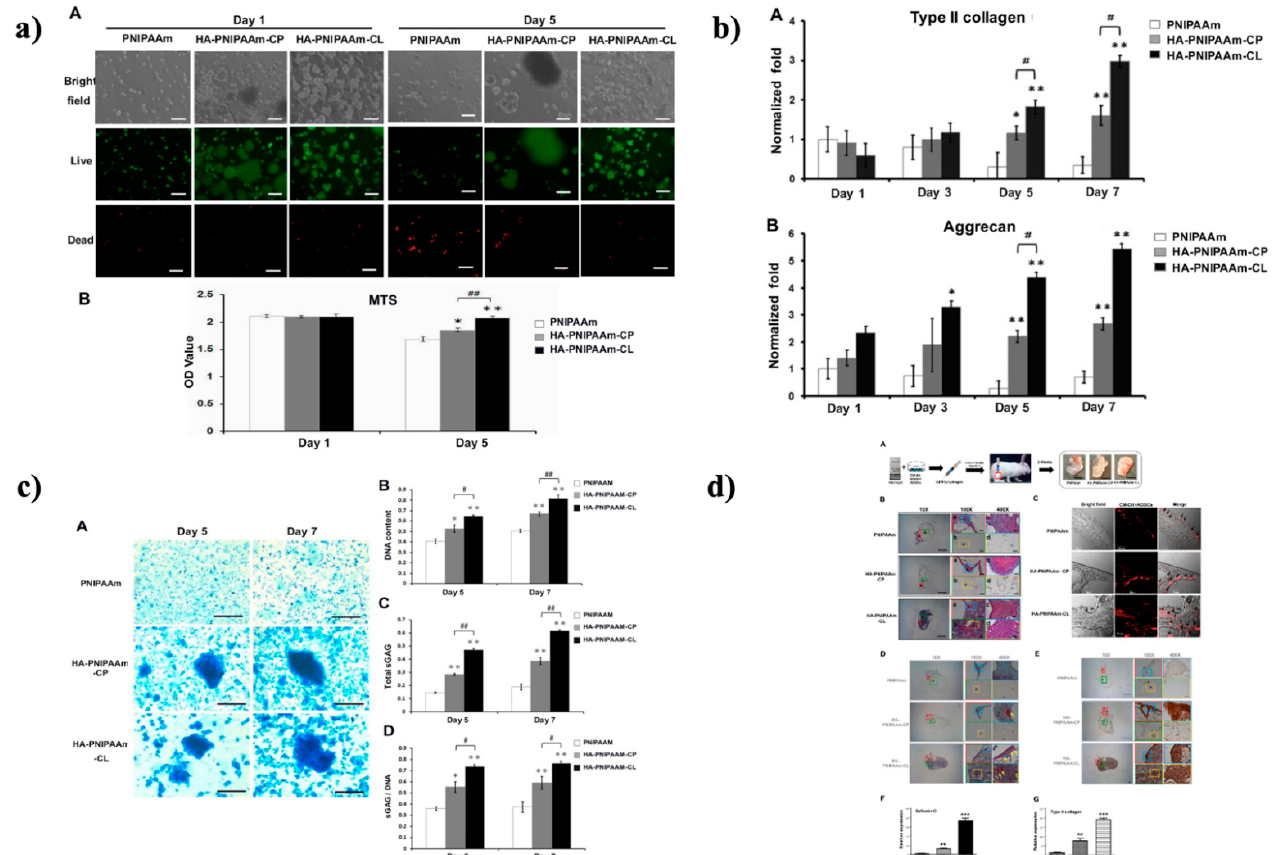
Figure 4. ( a ) The cytocompatibility and cell survival of rADSCs were improved by HA-modified PNIPAM hydrogels. Using (A) live and dead staining and (B) an MTS assay, cell survival of rADSCs encapsulated in PNIPAM, HA-PNIPAM-CP, and HA-PNIPAM-CL hydrogels was determined during days 1 and 5. ( b ) In rADSCs cultivated in PNIPAM, HA-PNIPAM-CP, and HA-PNIPAM-CL hydrogels for 1, 3, 5, and 7 days, the chondrogenic indicators of gene expression of (A) type II collagen and (B) aggrecan were detected. Collagen type II and aggrecan mRNA expression levels in rADSCs cultivated in HA-modified hydrogels are expressed and normalized in comparison to rADSCs cultured in PNIPAM hydrogels, which is designated as 1. ( c ) At days 5 and 7, there was enhanced cell aggregation and cartilaginous matrix sGAG production in rADSC cultured HA-modified PNIPAM hydrogels in vitro. (A) Glycosaminoglycans stained with Alcian blue (sGAG). (B) The DMMB assay was used to quantify the production of sGAG. ( d ) In vivo evaluation of the increase of neocartilage development in rADSCs/HA- PNIPAM-CL constructions using a rabbit model. (A) Illustration of the intraarticular injection of the rADSC/hydrogel constructions into the synovial cavity of rabbit knees. After 3 weeks, injected rADSC/hydrogel constructions were collected from rabbit synovial cavities and analyzed using (B) H&E staining, (C) confocal microscopy for pictures of bright fields, and CM-DiI-labeled rADSCs (red, arrows), (D) safranin-O fast green staining showing sGAG deposition (arrows), and (E) IHC staining for type II collagen synthesis (brown). Normalized relative to the PNIPAM group, which is defined as 1. Quantification examination of safranin-O staining (F) and type II collagen staining (G). Scale bar: 100 µ m. (*), (**), and (***) represented p < 0.05, p < 0.01, and p < 0.005 respectively, in contrast with the PNIPAM group. ( # ), and ( ## ) represented p < 0.05, and p < 0.01, respectively in contrast with the HA-PNIPAM-CP group